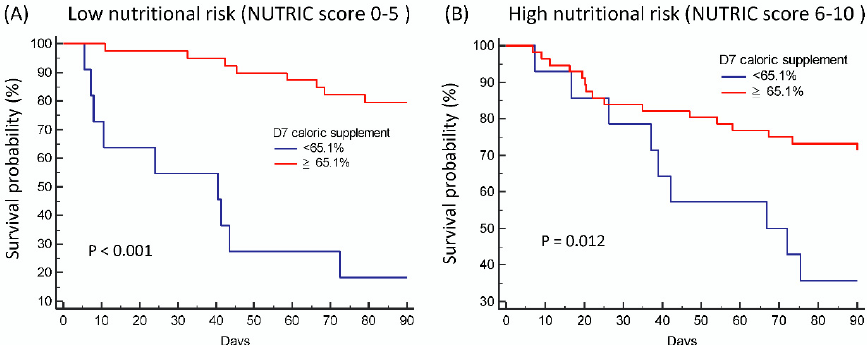
Figure 4. Impact of day 7 caloric meet on survival outcome in patients with high or low NUTRIC score. Patients with a lower day 7 caloric meet had a poor prognosis both in those with ( A ) low nutritional risk (NUTRIC score 0–5) and ( B ) high nutritional risk (NUTRIC score